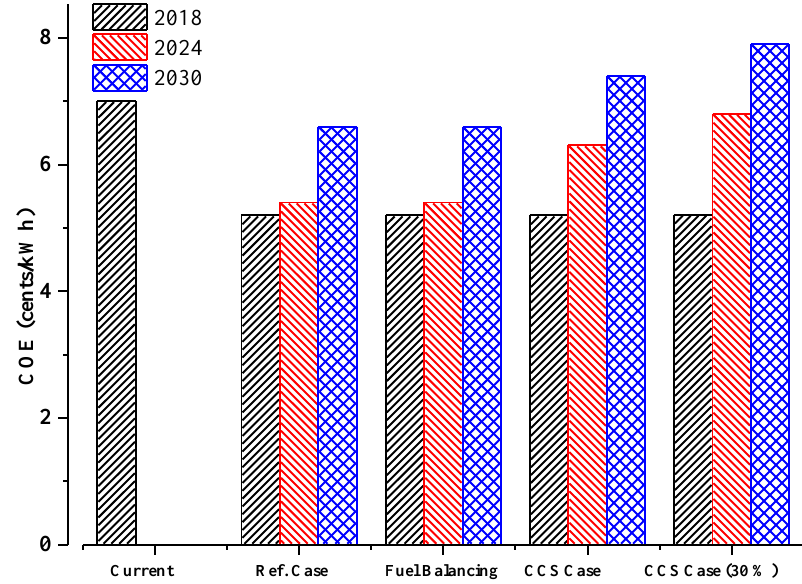
Figure 16. Cost of electricity comparison for all cases of summer low GDP.